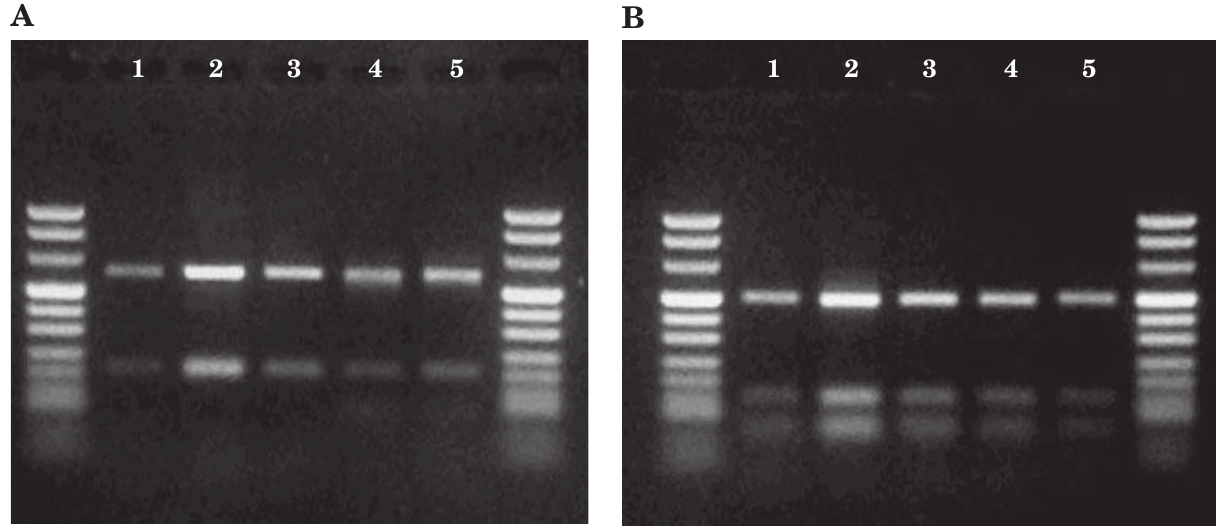
Fig.1. Restriction analysis of internal transcribed spacer portions of the nuclear-encoded ribosomal RNA gene clus- ter amplified by a polymerase chain reaction, digested with A, Alu I or B, Csp 6I, and electrophoresed in 1.5% agarose gels stained with ethidium bromide. Lanes 1 to 5 contain DNA of Fomitiporia punctata isolates obtained from the Comunidad Valenciana region: 1, San Antonio; 2, Benicolet; 3-4 San Antonio; 5, Requena. The unlabelled, outside lanes contain DNA molecular weight marker VIII (Boeheringer GmbH, Mannheim, Germany) as a size